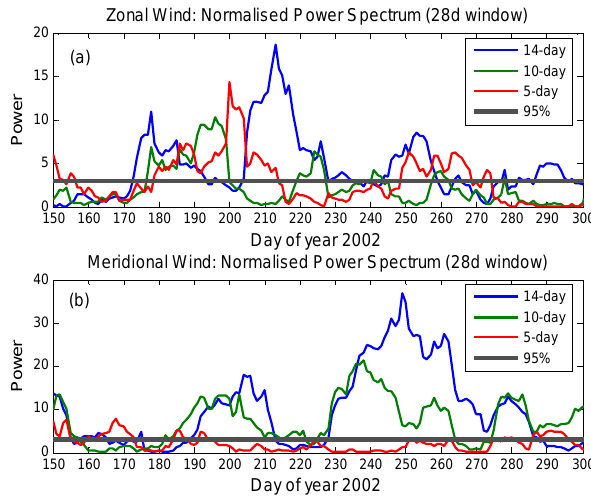
Fig. 6. The normalised power spectrum of the zonal wind (a) and meridional wind (b) 14-, Fig. 6. Normalised power spectrum of the zonal wind (a) and merid- ional wind (b) 14-, 10-, and 5-day components for SANAE HF 10-, and 5-day components for SANAE HF radar. The horizontal line represents the 95% radar. The gray horizontal line represents the 95% confidence confidence level.